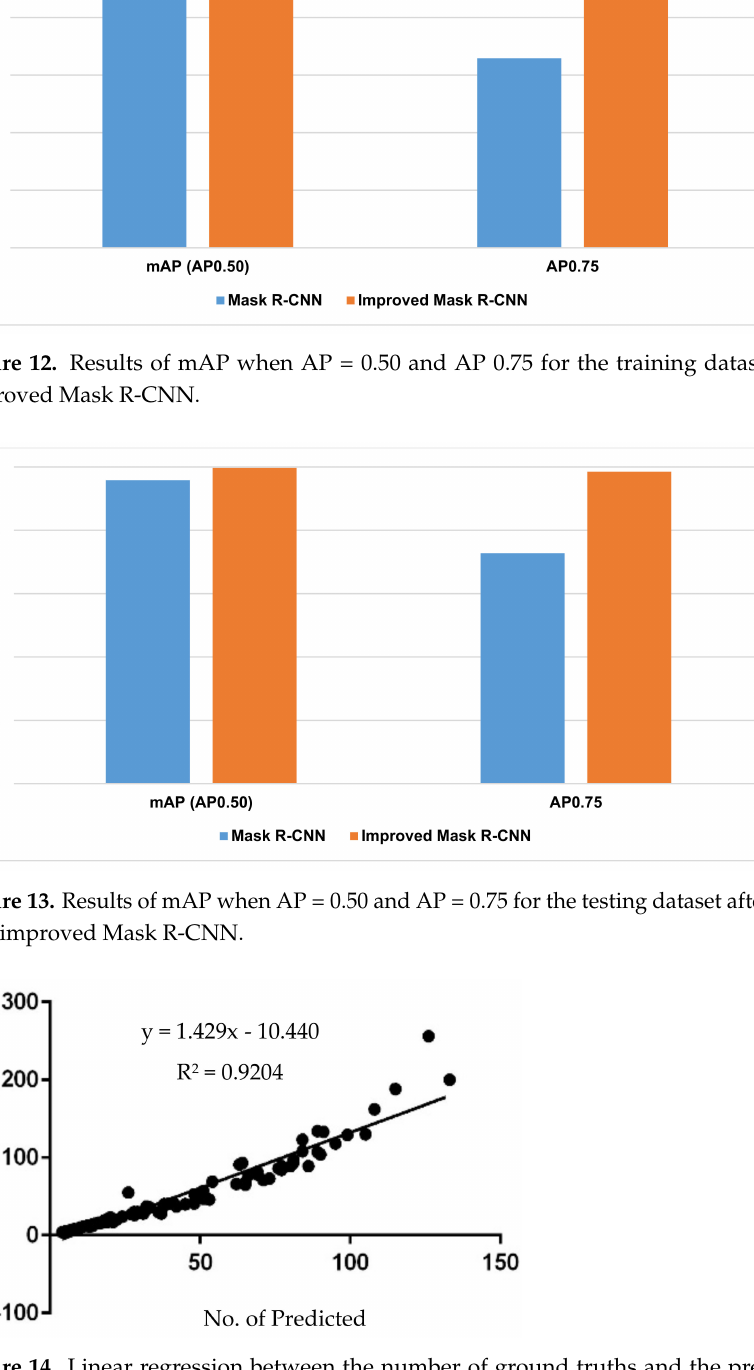
Figure 14. Linear regression between the number of ground truths and the predicted number of shrimps for 100 images in the training dataset for the default Mask